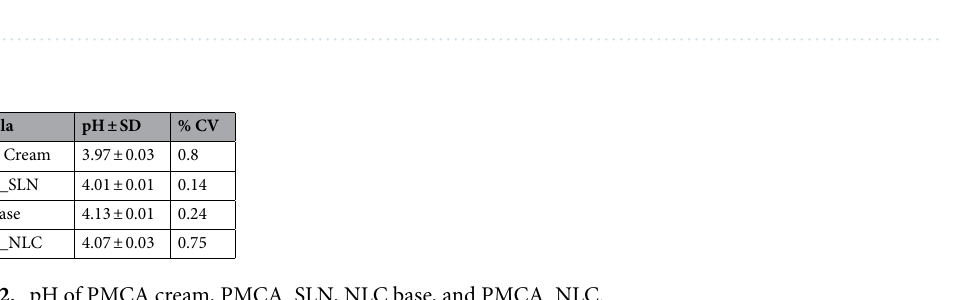
Table 2. pH of PMCA cream, PMCA_SLN, NLC base, and